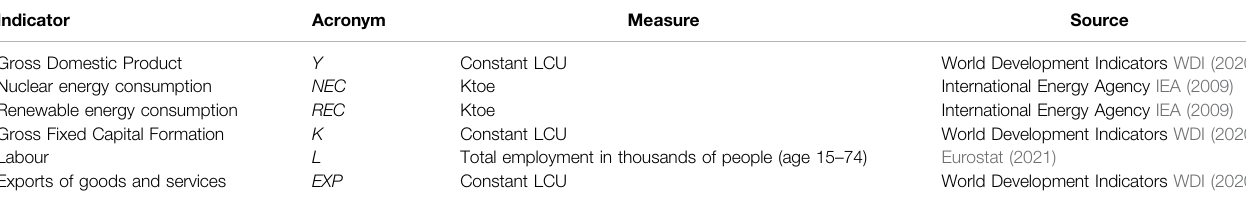
TABLE 3 | Data information. Indicator